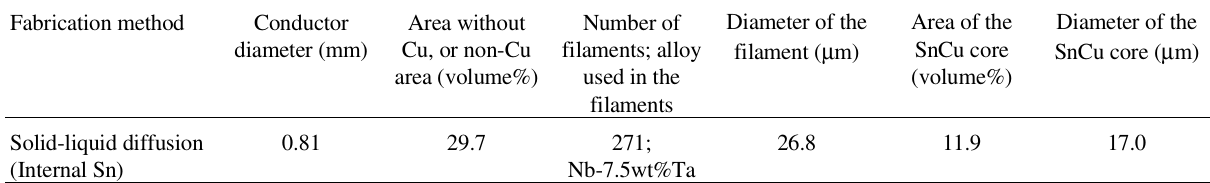
Table 1. Characteristics of the (Nb,Ta) 3 Sn superconductor